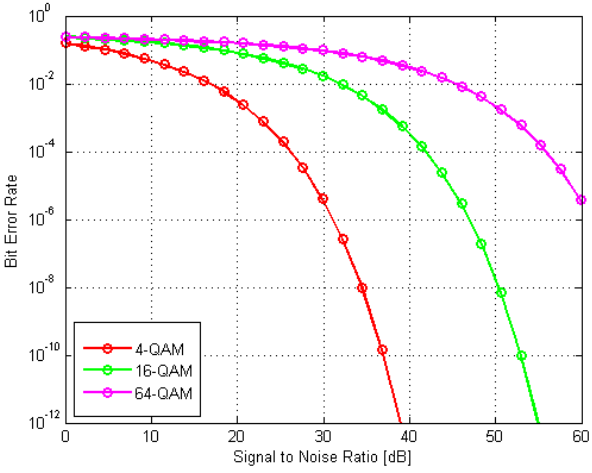
Figure 1. “Waterfall”—steep BER vs SNR curves (for Nyquist BW).